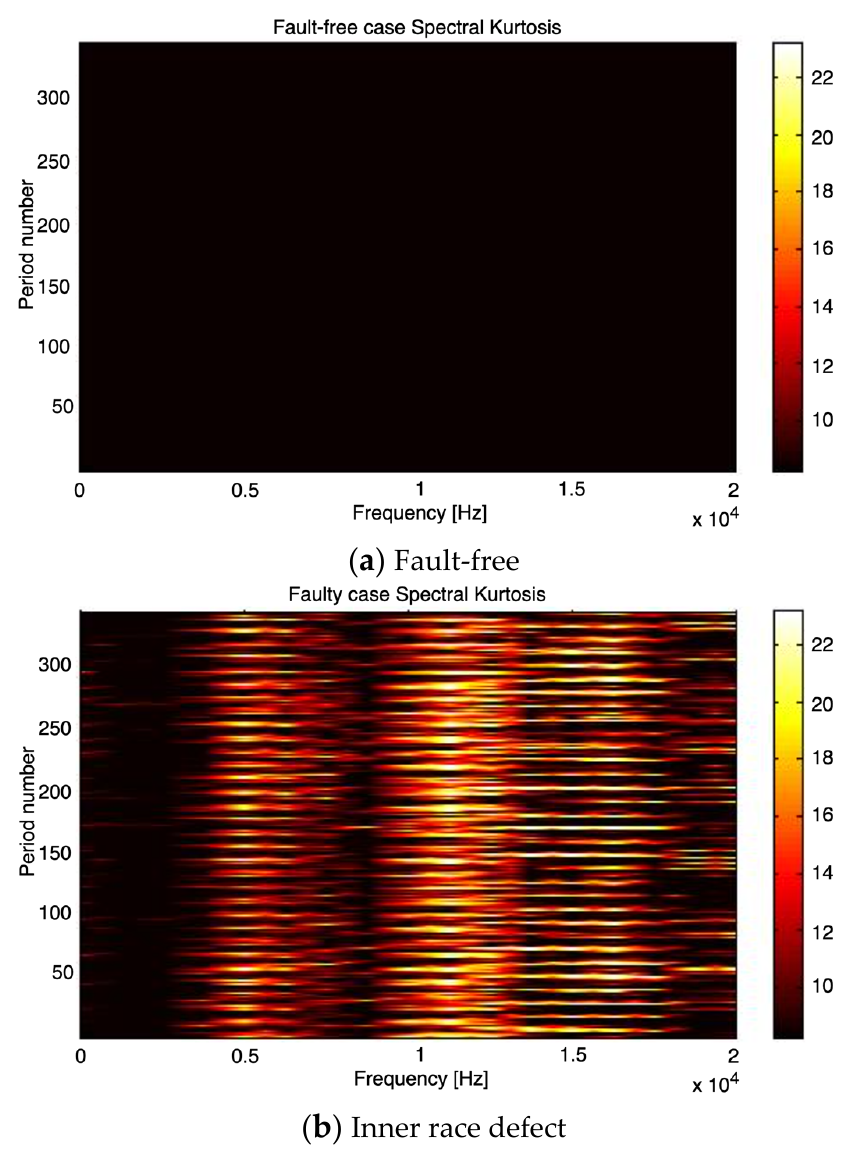
Figure 4. Spectral kurtosis for consequent bearing vibration segments.